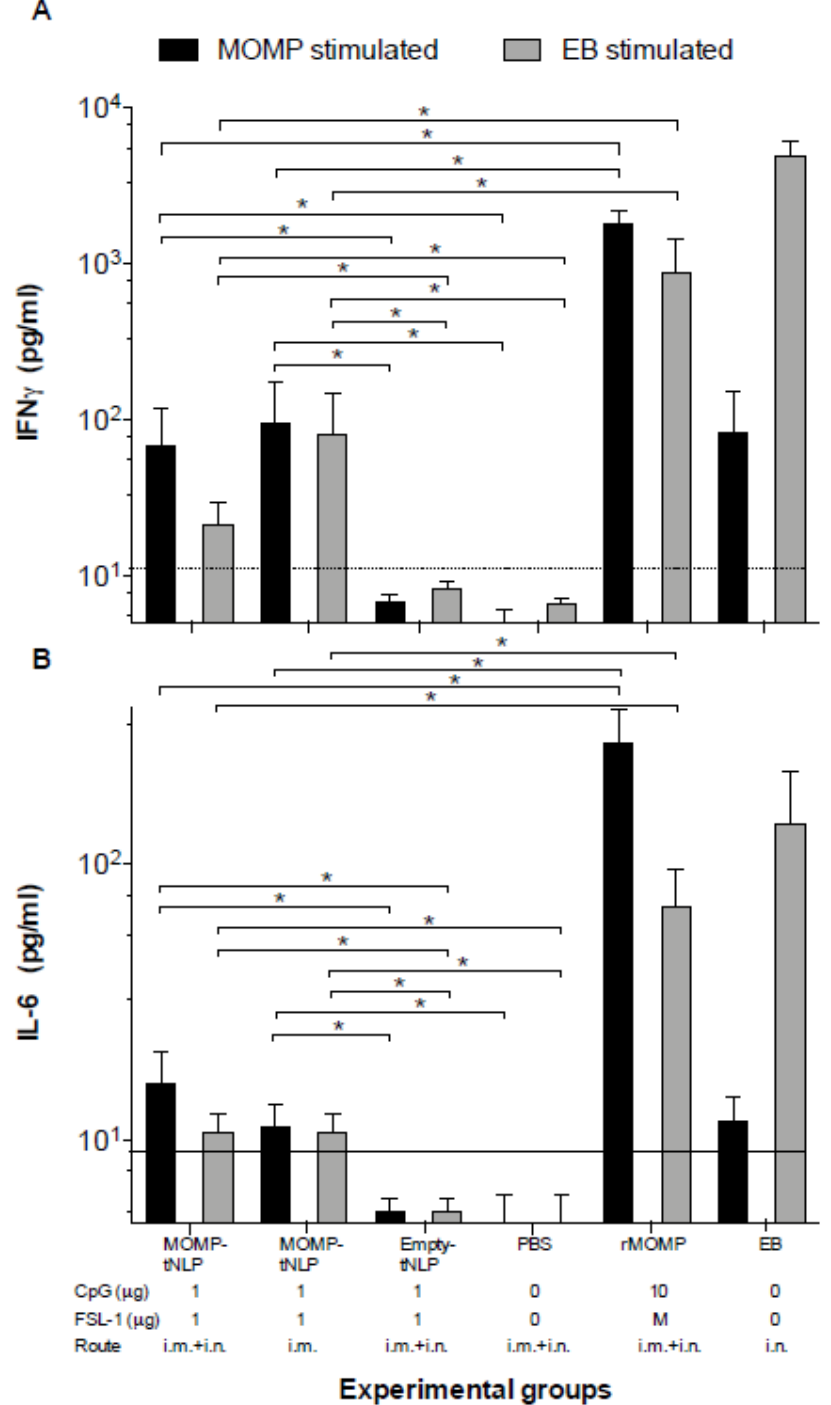
Figure 3. Levels of ( A ) IFN- γ and ( B ) IL-6 produced by T cells stimulated with EB or MOMP/APols the day before the C. muridarum i.n. challenge. The day before the challenge, mice were euthanized, their spleens collected, and T-cells purified using a nylon wool column. Purified T-cells were stimulated in vitro with C. muridarum -EB or with -rMOMP in APols. Cytokines were measure in the tissue culture supernatants. Horizontal dotted line represents the limit of detection. * p < 0.05 by ANOVA.